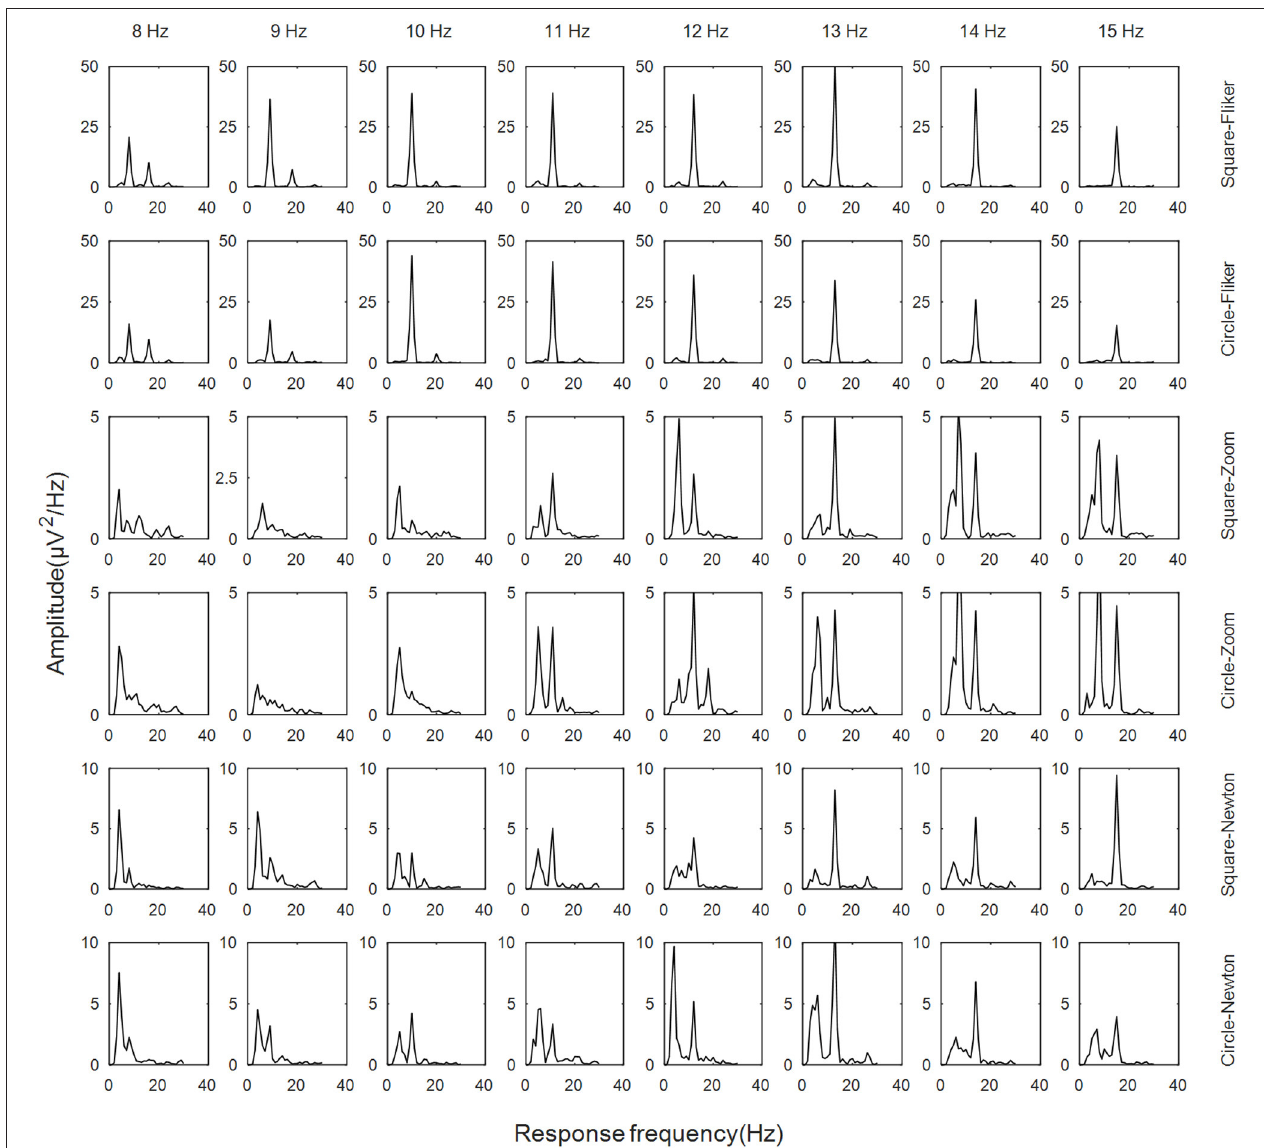
FIGURE 4 | Spectrum of the six